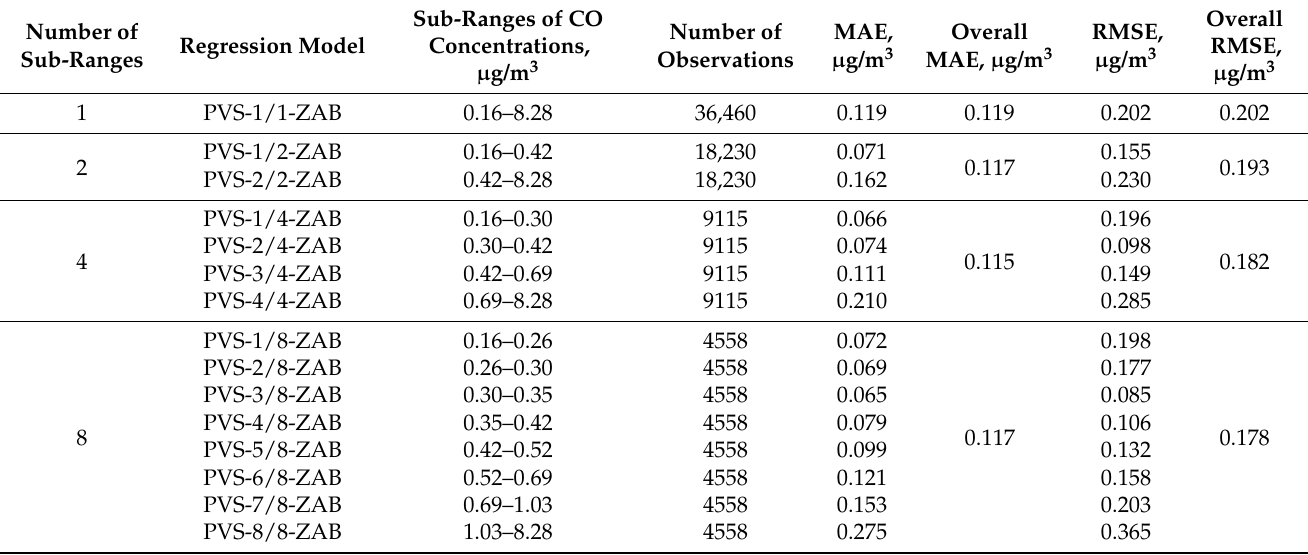
Table 23. Values of approximation errors of CO concentrations in PVS models, Zabrze 2011–2016.